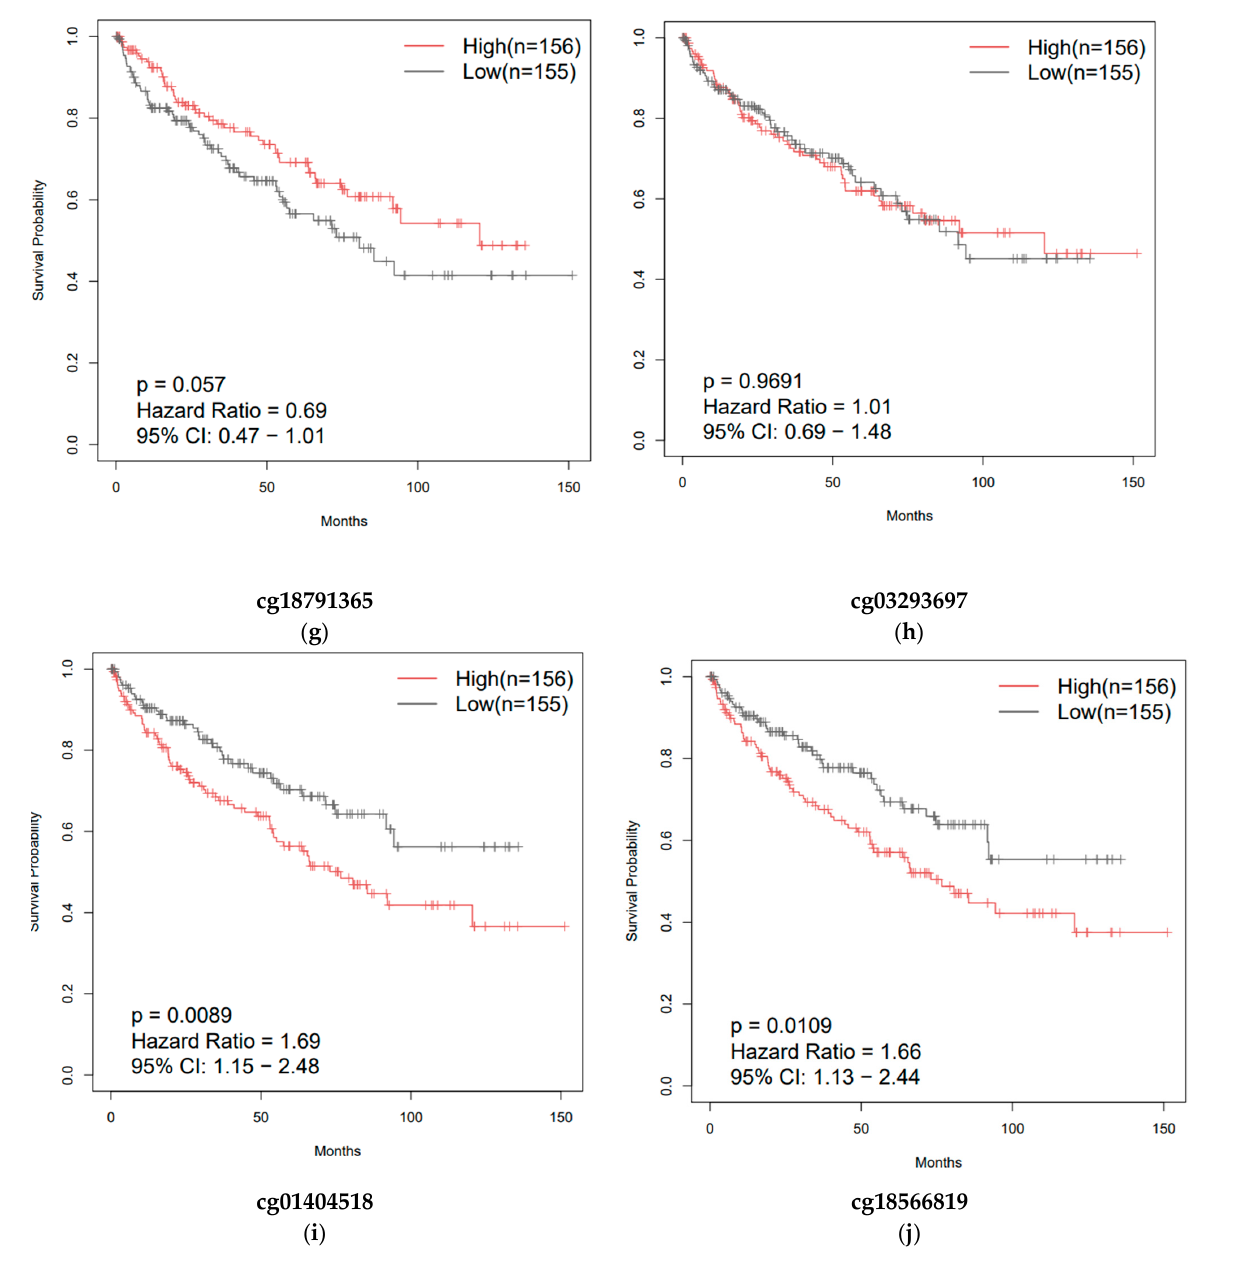
Figure 4. Methylation status of ZNF433 CpG loci and ZNF433 gene expression in normal and clear-cell renal cell carcinoma (ccRCC) tissues. ( a ) Methylation analysis between normal and ccRCC tissues revealed that CpG loci associated with ZNF433 were differentially methylated and statistically significant ( p < 0.01). In addition, analysis of CpG foci in aggregate (last panel) revealed that the ZNF433 gene significantly hypermethylated ( p = 2.2 × 10 − 16 ) relative to the normal tissues. ( b ) Correlational analysis between methylation status at CpG foci and ZNF433 protein expression revealed hypermethylation correlated with protein downregulation ( p = 2.2 × 10 − 16 ). ( c – j ) KM survival plots for CpG islands that displayed differential methylation.